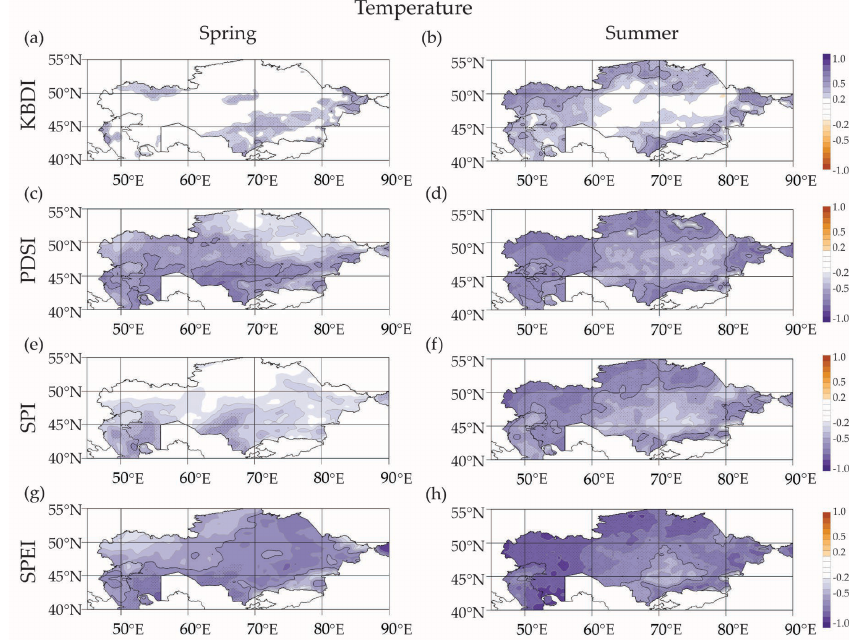
Figure 8. The spatial distribution of correlation coefficients between air temperature and dryness indices in the spring (left column) and summer (right column) seasons. The areas with statistically significant correlation coefficients ( p < 0.05) are shaded. The color scale for KBDI is inverted as an increase in KBDI corresponds to the growth of aridity, while for other indices, the higher values Climate 2022 , 10 , 144 coincide with wetter conditions. ( a , b ) KBDI, ( c , d ) PDSI, ( e , f ) SPI, ( g , h ) SPEI.